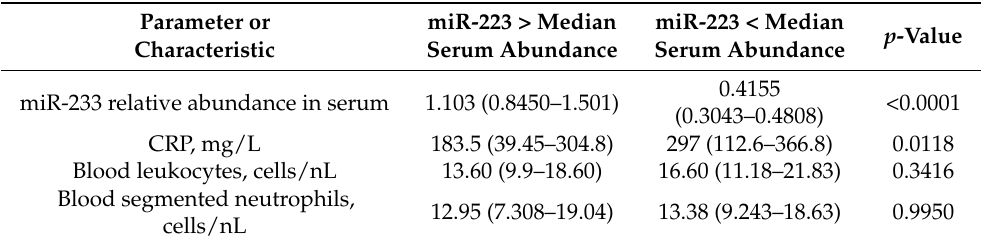
Table 1. Relative miR-223 abundance and clinical characteristics of the CAPNETZ cohort. Parameter